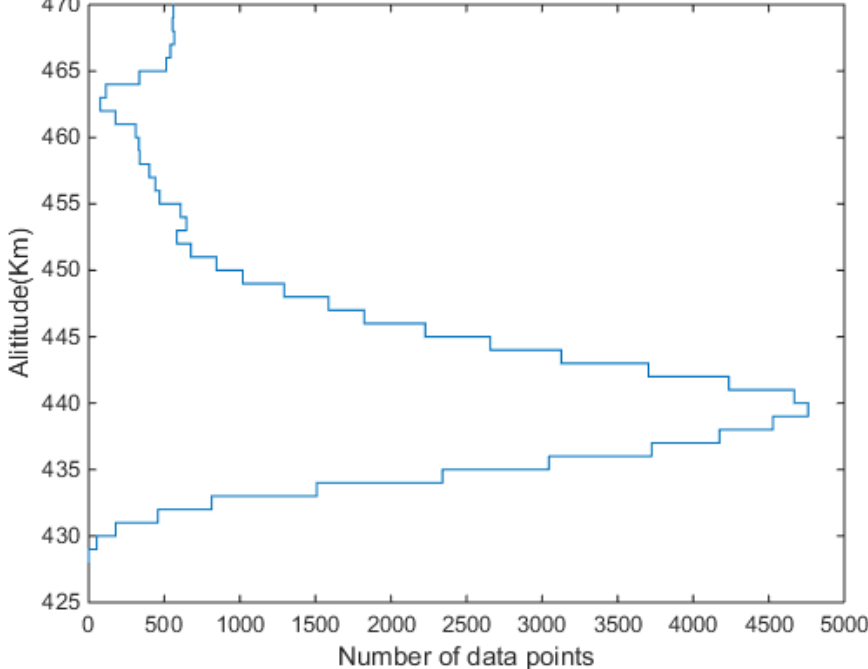
Figure 1. The number of data points with altitude, with the maximum data point concentrated at an altitude of 440 km.